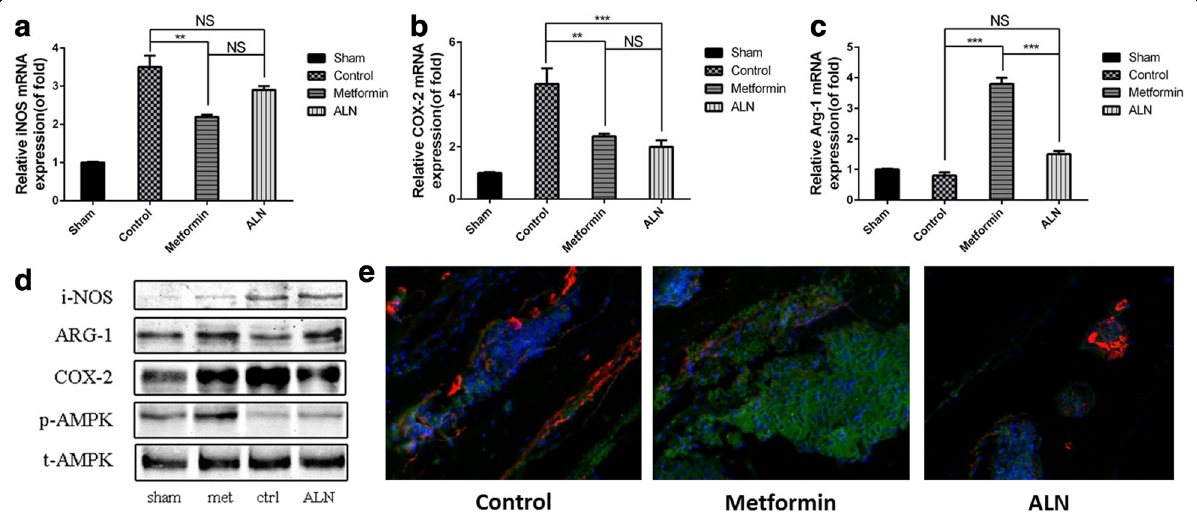
Fig. 6 mRNA expression of proteins associated with macrophage phenotype and changes of protein expression according to western blot analysis in mouse calvarial tissue after implantation of UHMWPE particles and treatment with saline (control), metformin, or ALN. Relative mRNA expression of iNOS ( a ), COX-2 ( b ), and Arg-1 ( c ) among tissues from the different groups. d Protein expression of iNOS, COX-2, Arg-1, p-AMPK, and t-AMPK among tissues from the different treatment groups. e Double-labelling immunofluorescence of p-AMPK (green) and macrophage marker CD68 (red) in control group, metformin-treated group and ALN-treated group. (Cropped gels/blots are used here, and the full-length gels and blots are shown in Additional file 1: Figure S5.) *** P < 0.001; ** P < 0.01; * P < 0.05; NS, P >